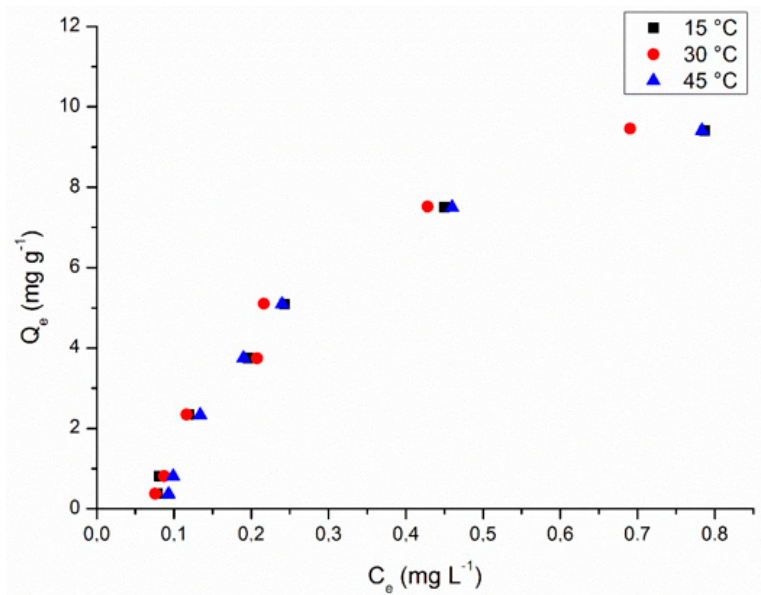
Figure 5. Adsorption isotherms (methylene blue (MB) concentration = 1.0–20.0 mg L − 1 , adsorbent concentration = 2.0 g L − 1 , particle size = 30 mesh, sample volume = 50 mL, contact time = 24 h, temperature = 15–45 °C, stirring speed = 150 rpm).